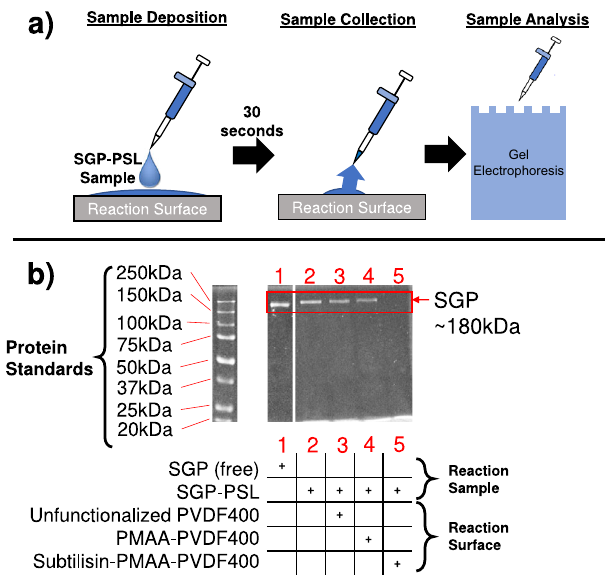
Fig. 9 Characterization of particle-bound protein denaturation via enzyme interaction of functionalized membrane. Analysis of 100 nm SGP- functionalized PSL after a 30 s reaction with different membrane surfaces via b Sodium dodecyl-sulfate polyacrylamide gel electrophoresis (SDS- PAGE). Approximately 2.6 μ g of protein was loaded in each well (except the SGP-only lane with ~5.2 μ g) with reactions carried out at total protein concentrations of ~87.5 μ g/mL at pH of 7.8 and 23 °C. These experiments were performed in duplicate (see Supplementary Fig. 12 for the complete gel image and the second experiment